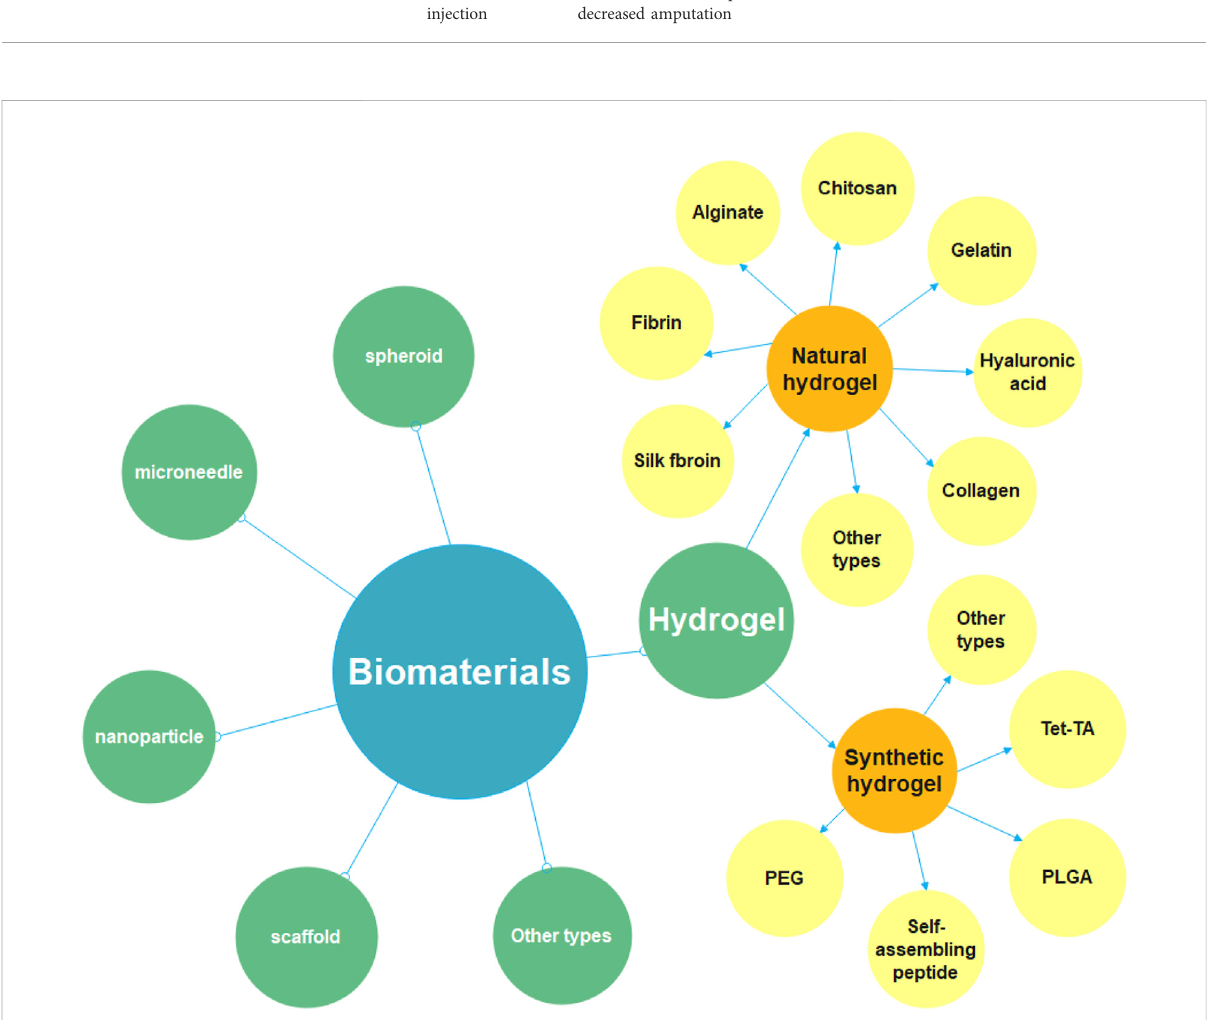
FIGURE 5 Diagramoftheclassi fi cationofbiomaterials.Biomaterialsincludehydrogel,spheroid,microneedle,nanoparticle,scaffoldandsoon,thisreview focuses on hydrogel-related research. It can be divided into natural hydrogel and synthetic hydrogel. The natural materials for preparing hydrogels include chitosan, gelatin, fi brin, alginate, collagen, hyaluronic acid, silk fi broin, etc. The synthetic materials for preparing hydrogels include polyethylene glycol (PEG), poly (lactic-co-glycolic Acid) (PLGA), self-assembling peptide (SAP), tetronic-tyramine (Tet-TA),